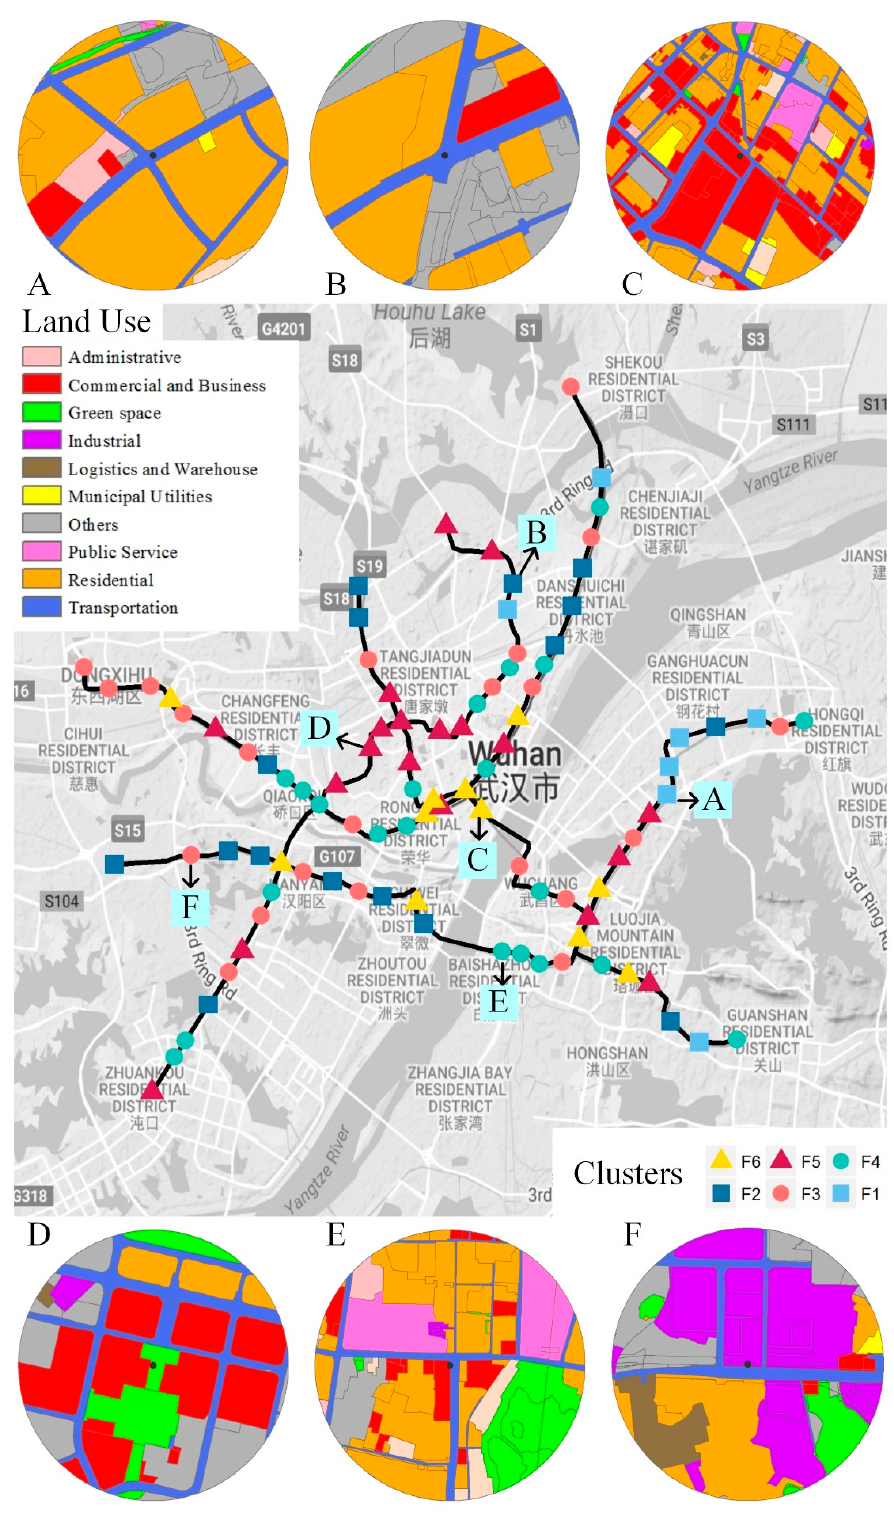
Figure 7. Spatial distributions of six function clusters. A: Tieji Road; B: Houhu Avenue; C: Jianghan Road; D: Wuhan CBD; E: Fuxing Road; F: Mengjiapu. Station A–F are examples of the six clusters respectively. As mapped in Figure 6, F1 and F2 cluster have the highest percentage (56.1% and 40%) of AC3 long overnight stay among all clusters. People visiting these stations mostly aim to return